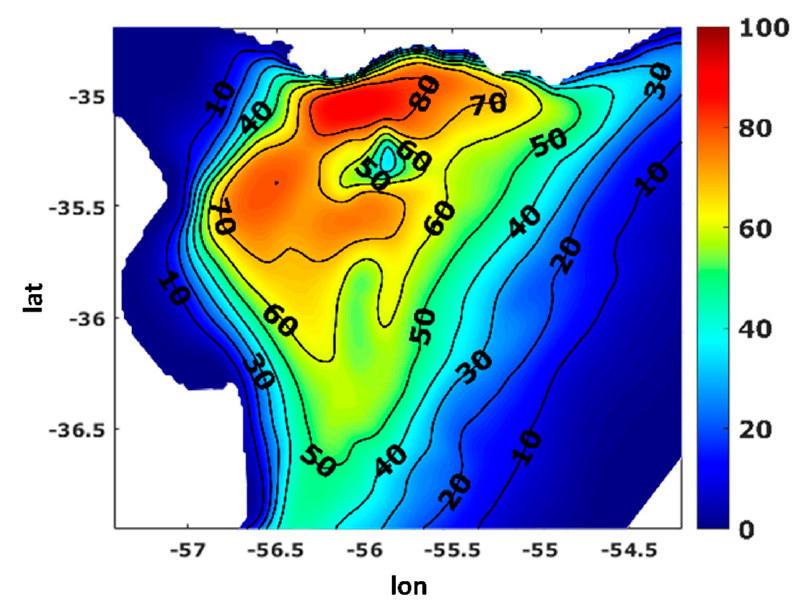
Figure 13. Frequency (percentage) associated with vertical salinity stratification higher than 5 ppt for the Río de la Plata obtained from hourly RPtide results for the period 2005–2015.